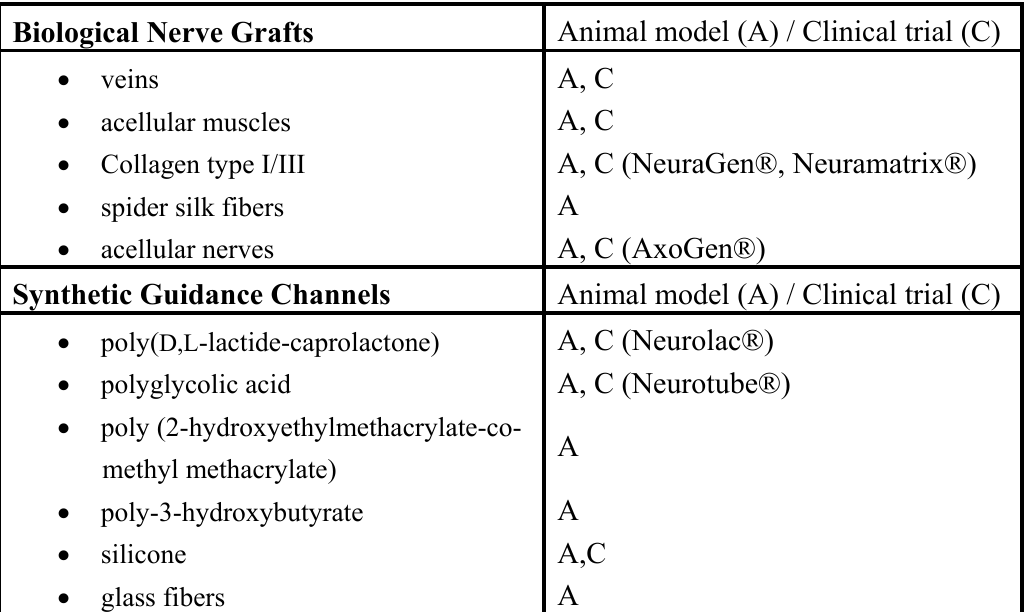
Table 1. Overview of different biological and synthetic nerve